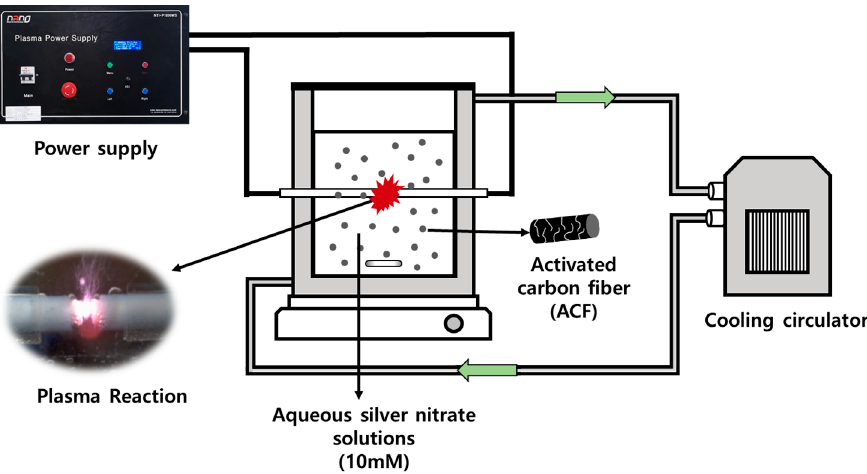
Figure 2. Schematic diagram of LPP method for preparation of Ag particle-precipitated ACF.